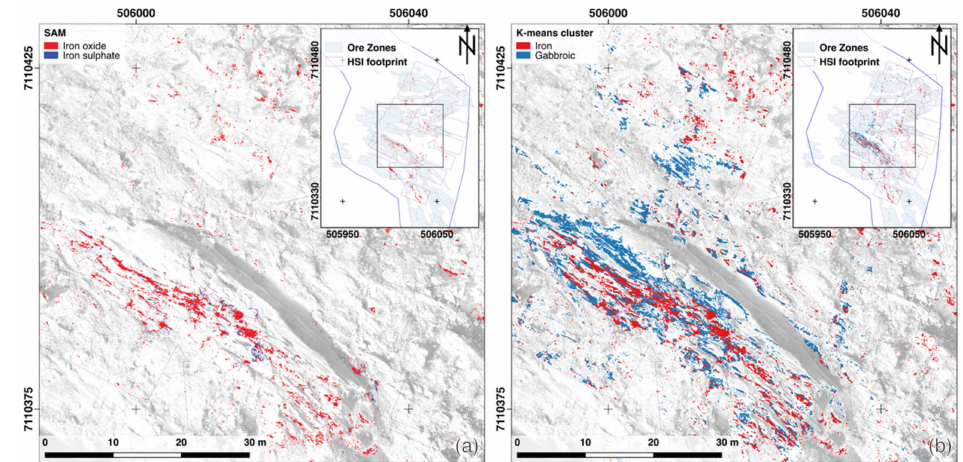
Figure 8. ( a ) Result of SAM mapping using input spectra from the USGS spectral library [49]. ( b ) Result of unsupervised k-means clustering, where two classes represent iron proxies and gabbroic rock surfaces. Di ff erent iron minerals are combined in the iron class.